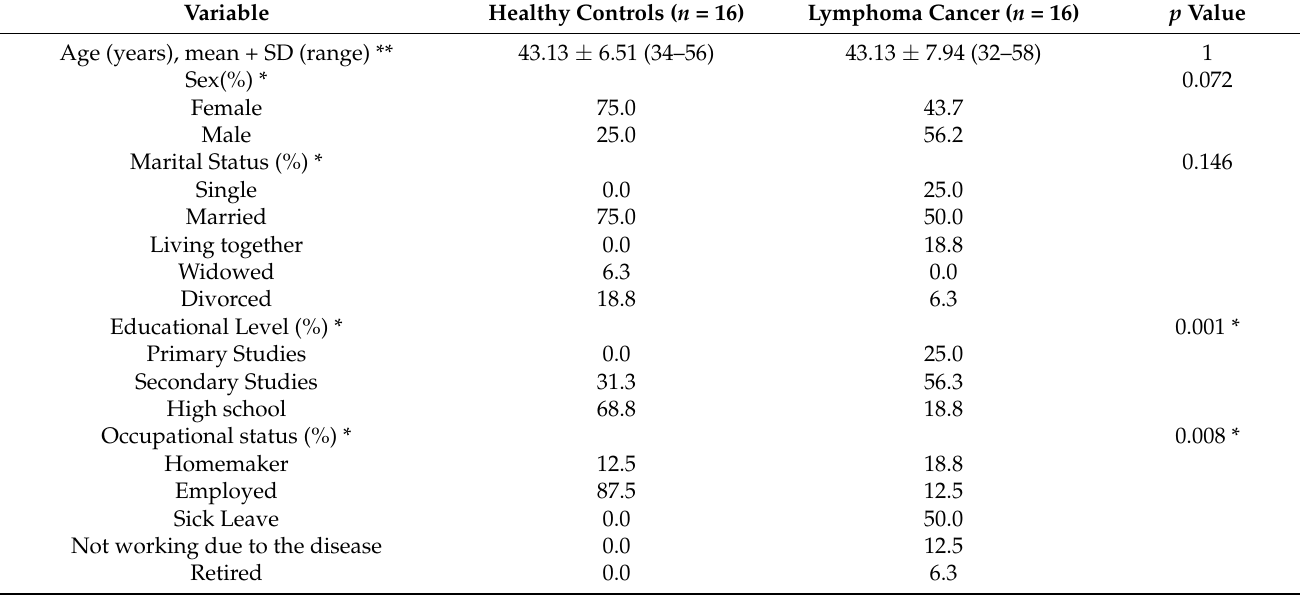
Table 1. Participant characteristics by study